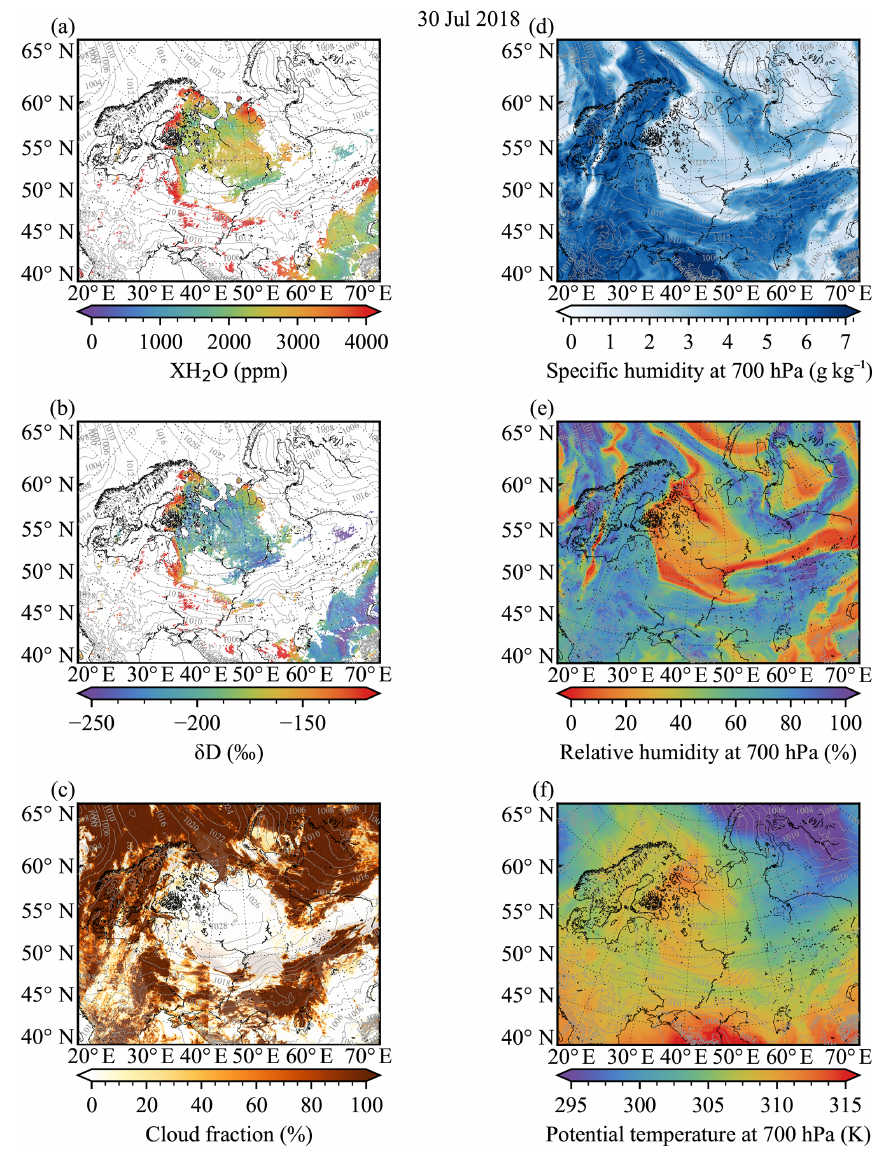
Figure 11. TROPOMI single-overpass results for H 2 O column (a) and δ D (b) over Europe on 30 July 2018; VIIRS cloud fraction on the same day (c) ; specific humidity (d) , relative humidity (e) , and potential temperature (f) at 700hPa from the ECMWF analysis product over Europe at 12:00UTC on 30 July 2018. The 700hPa level is chosen for the thermodynamic variables because it reflects the large-scale conditions in the lower troposphere above the continental boundary layer. The overlaying contours in all panels show mean sea-level pressure from ECMWF at 12:00UTC with a contour line distance of